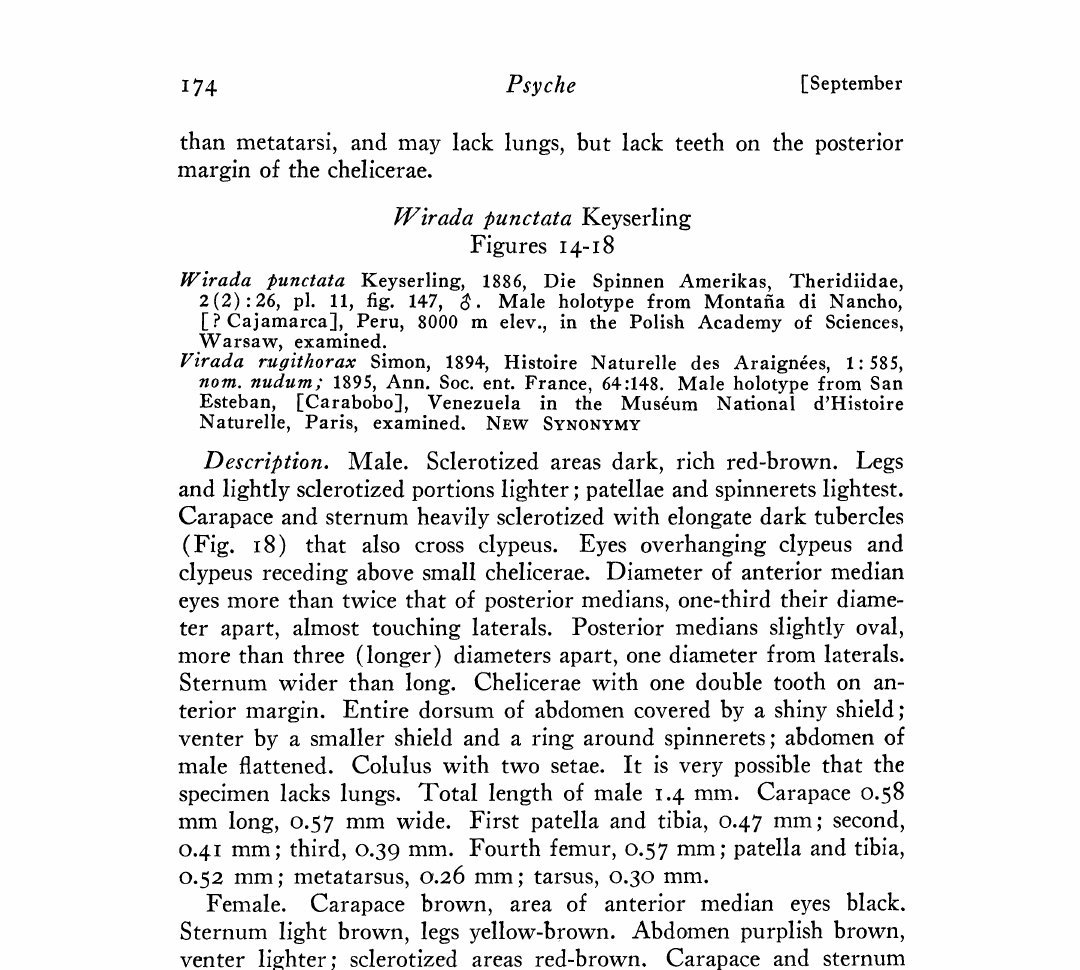
Figs. 14-18. ICirada punctata Keyserling. 14. Left palpus. 15. Female genitalia, dorsal view. 16. Epiynum. 17. Female. 18.